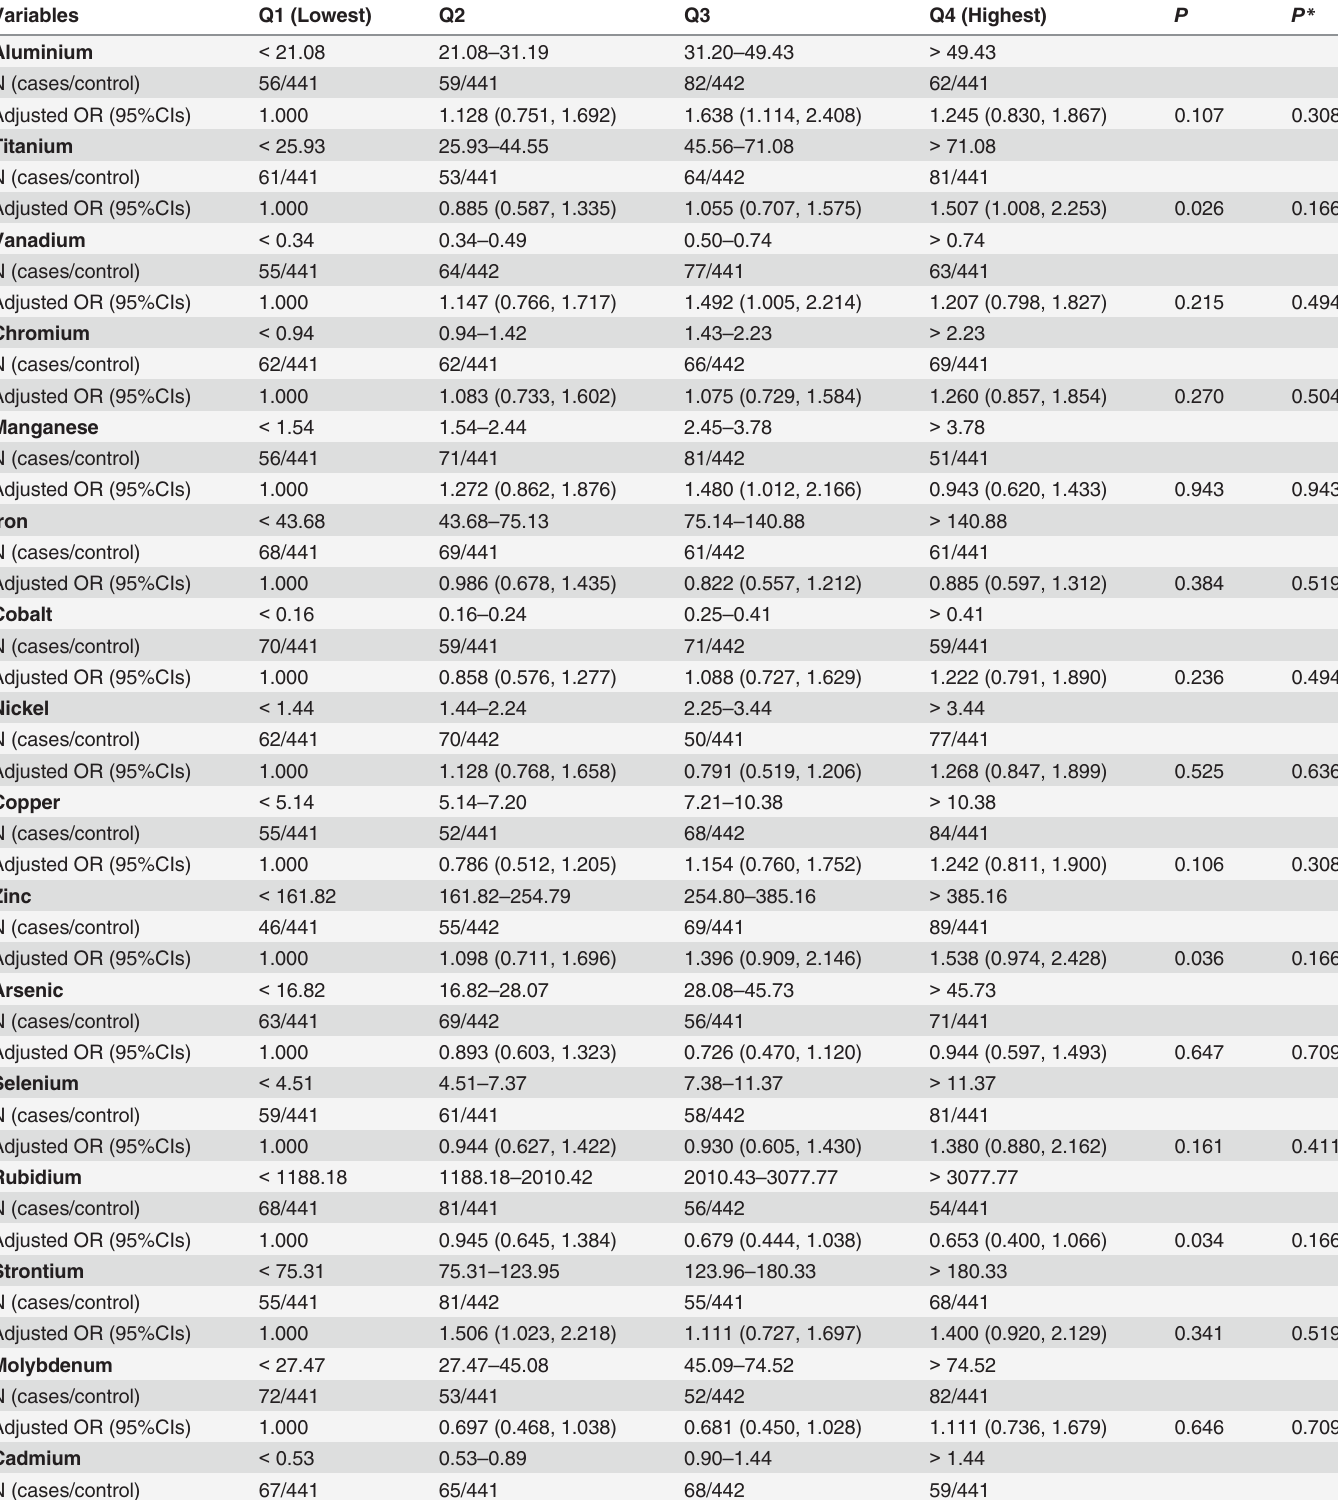
Table 4. Adjusted OR and 95% CIs of IFG risk by quartiles of urinary